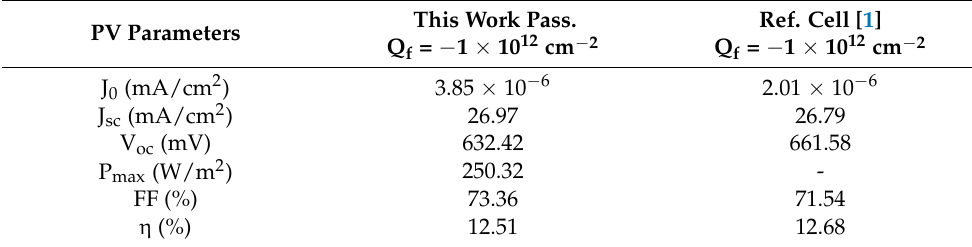
Table 1. Investigated model